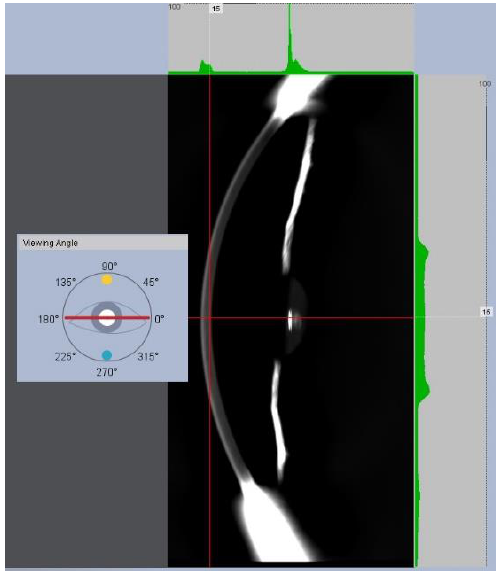
Figure 2. Optical density measurement at the posterior corneal location and horizontal viewing of the Scheimpflug camera.